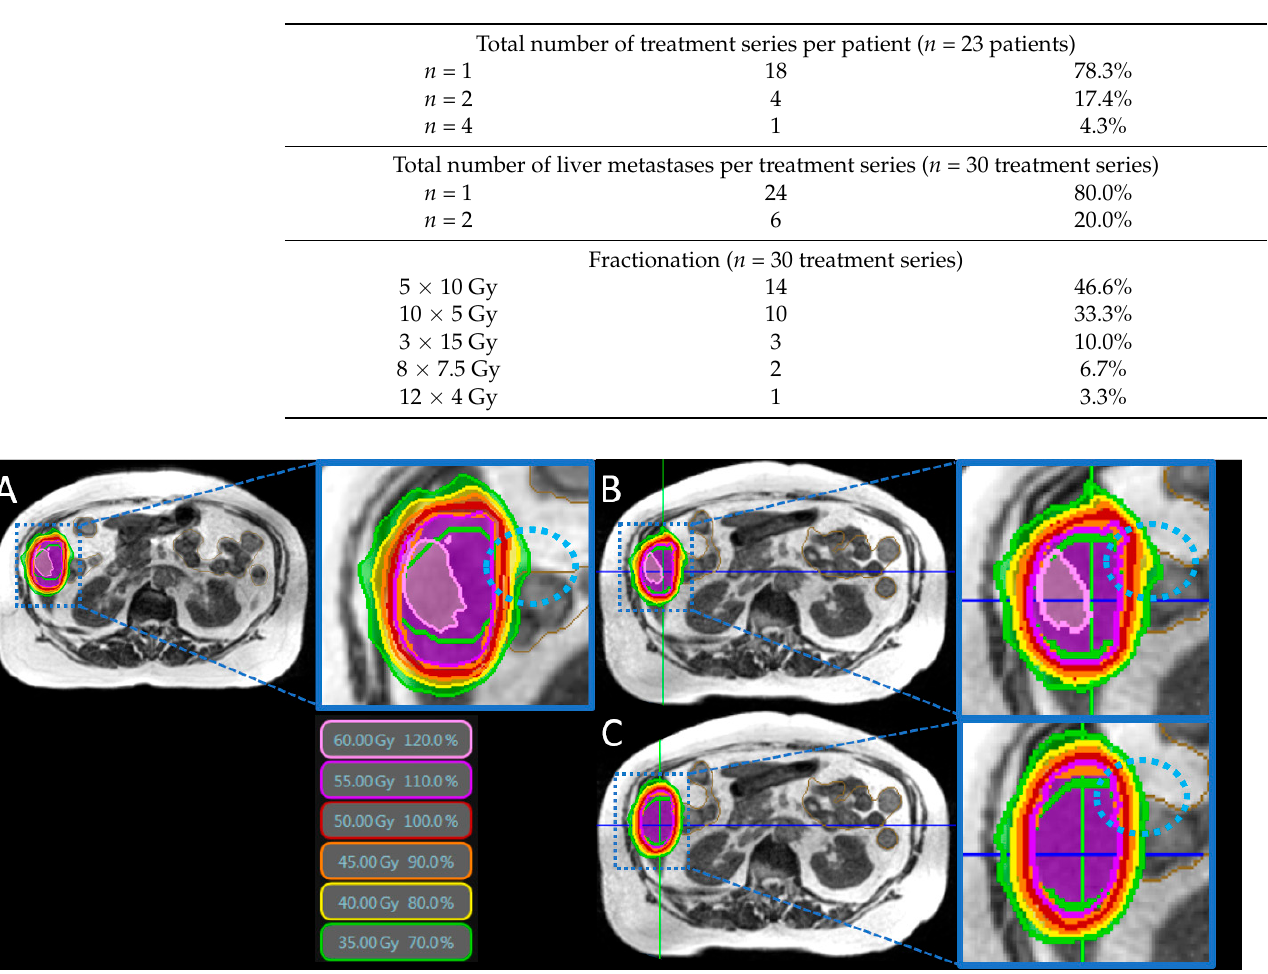
Figure 2. Planning objective violations. Proportion of fractions with one or more violation of the planning target volume (PTV; A ) coverage, PTV maximum dose (Dmax; B ) or organ at risk (OAR, C ) Dmax. PTV coverage violations were the most common violations and were significantly reduced through plan adaptation (predicted: 183 out of 200, 91.5%, adapted: 76 out of 200, 38.0%, p < 0.001; baseline: eight out of 30, 26.6%). Plan adaptation furthermore improved median PTV coverage (Figures 3A and 4; predicted: median 86.7% (range 70.9–98.0%); adapted: 95.0% (range 84.5–98.0%) p < 0.001; baseline: 95.0% (range 87.2–98.0%). Plan ad- aptation significantly increased the median biologically effective dose of the D95 (BED D95 ) by 3.2 Gy (Figure 3B); predicted: 72.0 Gy (range 29.7–110.8 Gy), adapted: 75.2 Gy (range 55.6–120.3 Gy), p < 0.001; baseline 100.0 Gy (range 67.2–112.5 Gy).